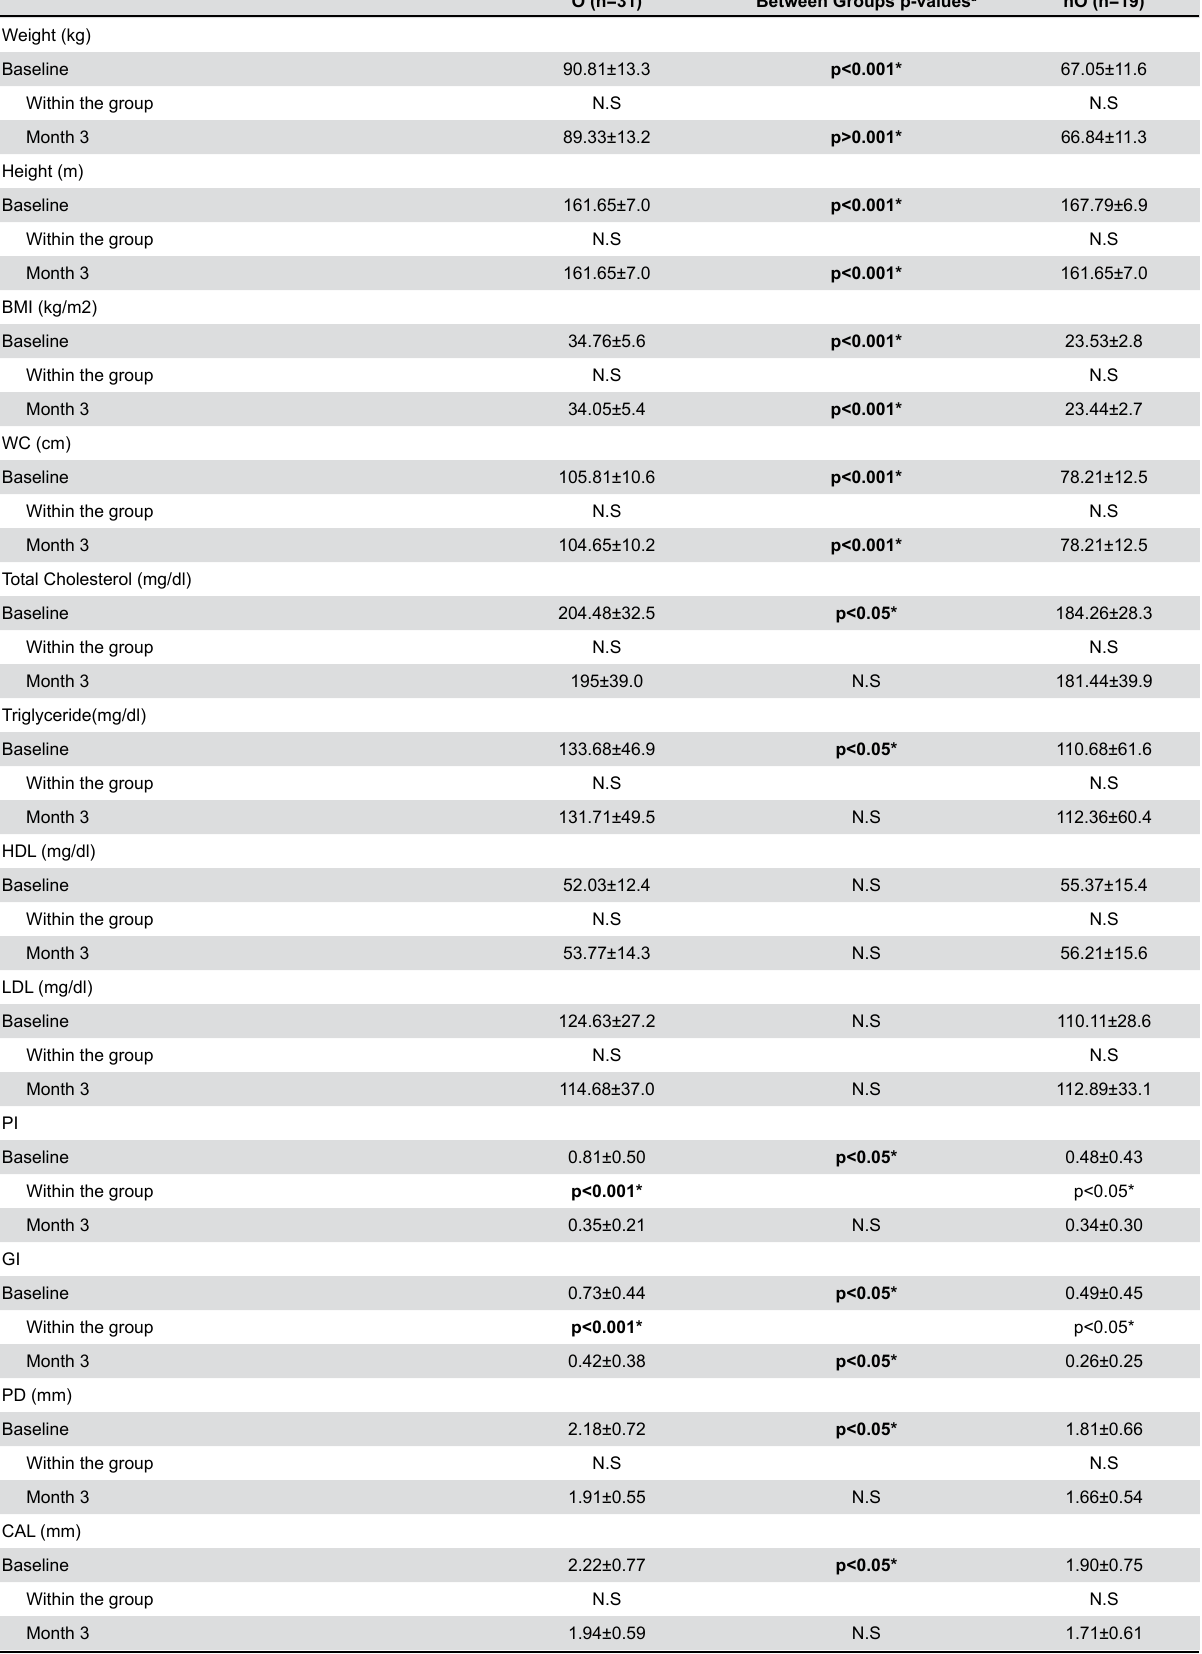
Table 2- Anthropometric, laboratory, periodontal parameters and total amounts of adipocytokines in GCF of O and nO